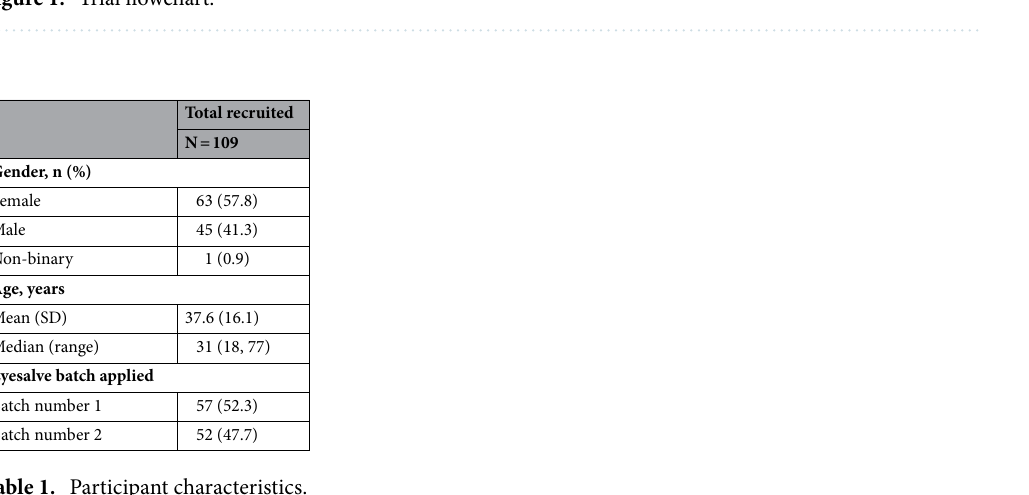
Figure 1. Trial flowchart.